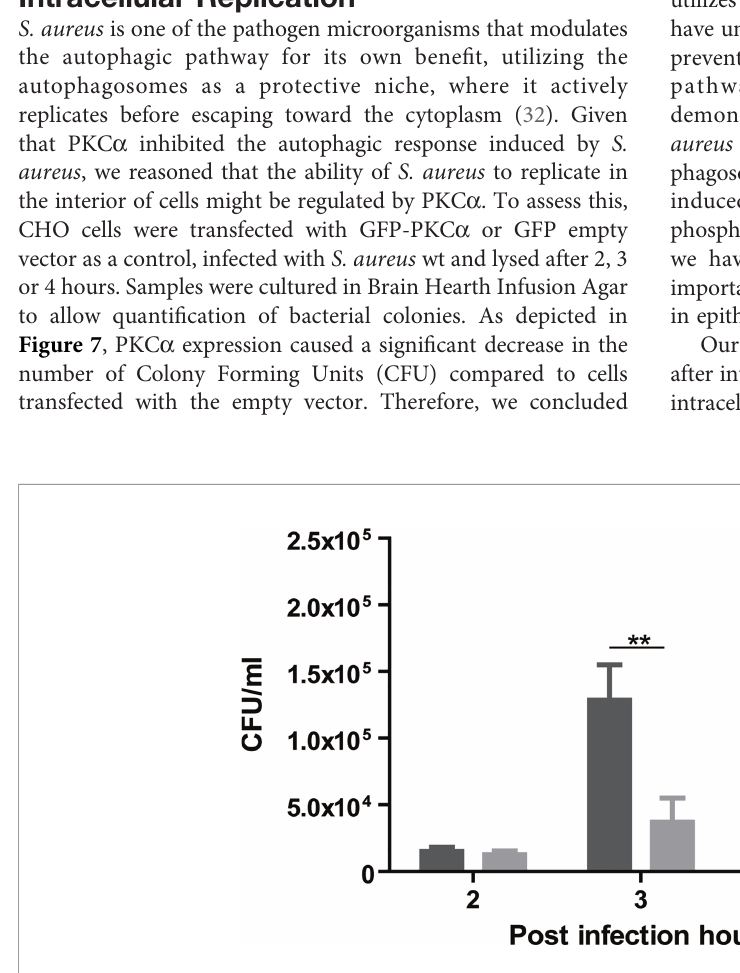
FIGURE 7 | PKC a decreases intracellular replication of S. aureus . Colony forming units (CFU) quanti fi cation (see Materials and Methods) of CHO cells overexpressing GFP-PKC a or GFPv and infected for 4 hours with S. aureus wt. Data are the mean ± SEM of three independent experiments. **p ≤